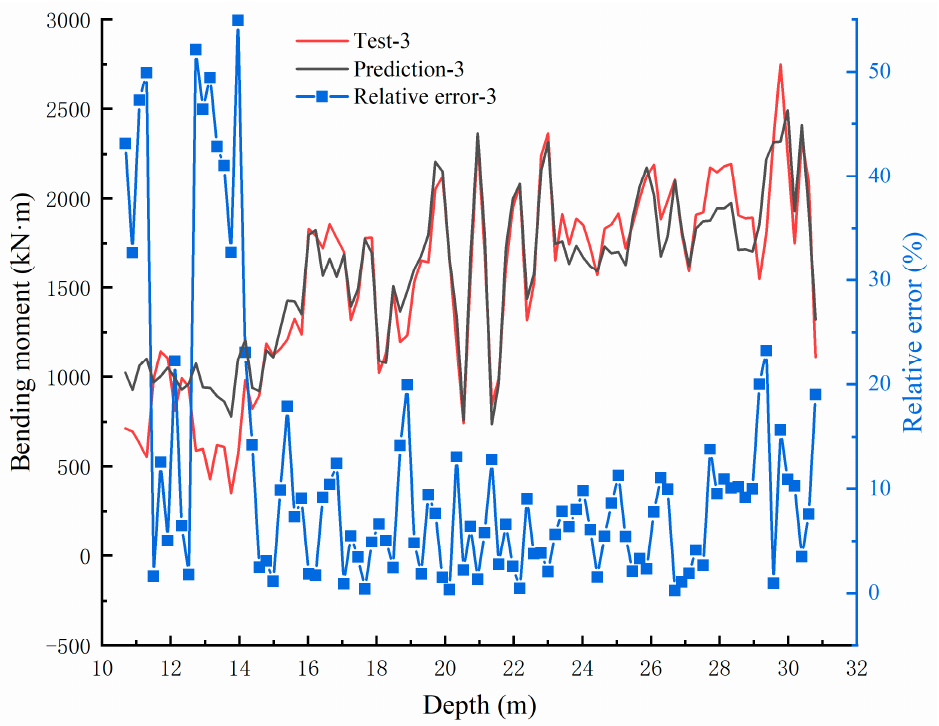
Figure 18. Bending moment comparison graph between Test-3 and prediction value and the error distribution curve.